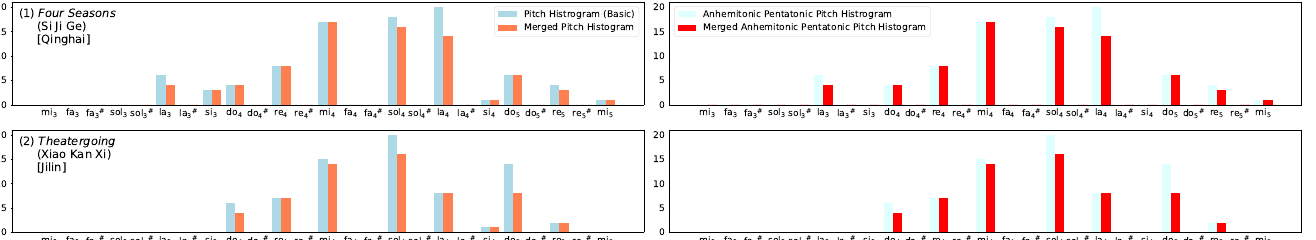
Figure 5. The movable do solfège-based basic pitch histograms (left column), merged pitch histograms (left column), anhemitonic pentatonic pitch histograms (right column), and merged anhemitonic pentatonic pitch histograms (right column) for two representative traditional Chinese anhemitonic pentatonic folk songs, with the original names (Hanyu Pinyin) in curved brackets and the provinces of the origin in square brackets. After removing the fa and si bins not belonging to the Chinese anhemitonic pentatonic scale for the basic and merged pitch histogram (left column, DoBell < 1), the anhemitonic pentatonic pitch histograms (right column) still have individual bins that violate the bell shape ( DoBell < 1). However, the merged anhemitonic pentatonic pitch histograms (right column) conform to the bell shape ( DoBell =